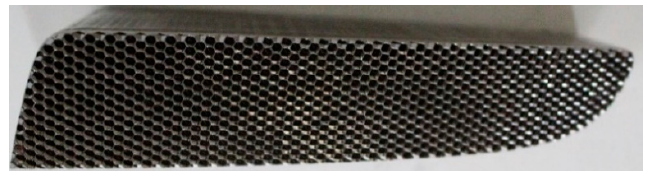
Figure 19. Comparison of the reflection efficiency R A of commercial CCCR, primary CCCR and optimized CCCR.